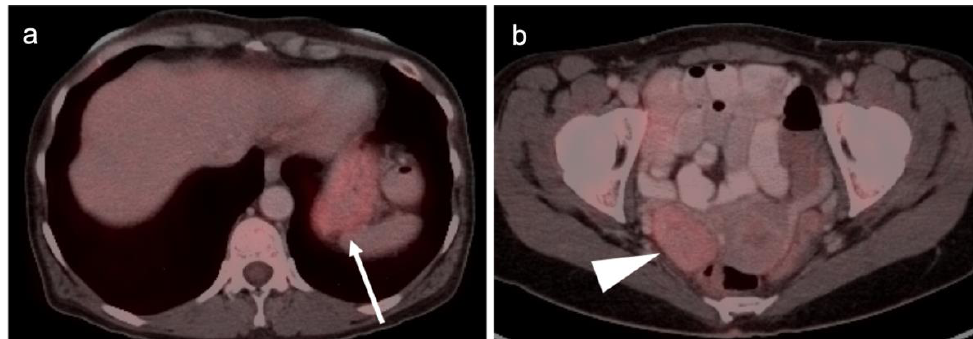
Figure 9. Mucinous cystadenocarcinoma of the ovary with peritoneal spread. ( a – e ) Axial FDG PET- CT images of the abdomen. ( a ) Small peritoneal implant (white arrow); ( b , c ) large mixed attenuation ovarian mass (white arrowheads). The solid components are hypermetabolic. ( c – f ) Areas of subtly metabolically active mucinous ascites (white arrows).